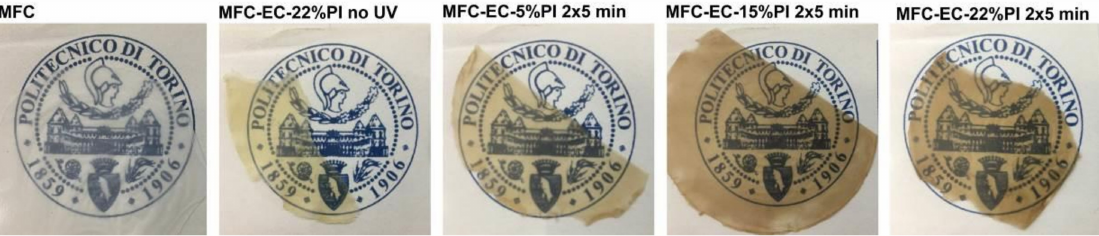
Figure 2. Photos of dry MFC mat, MFC-EC-22%PI composite before irradiation, and of composites irradiated for 2 × 5 min: MFC-EC-5%PI, MFC-EC-15%PI and